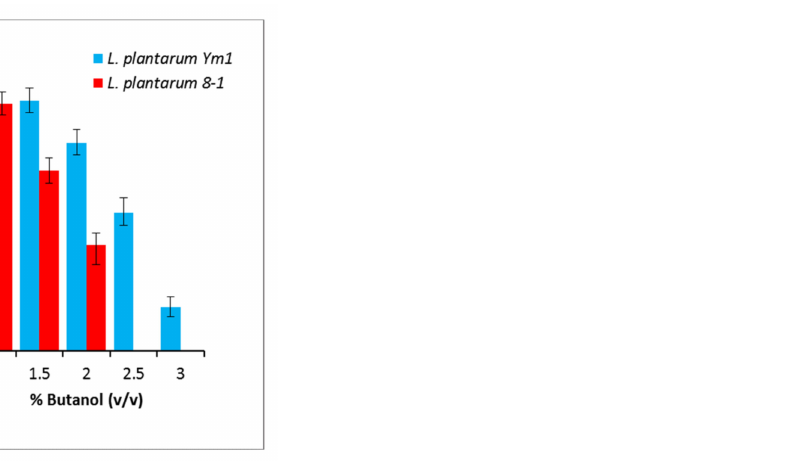
Figure 1. Relative growth rates of L. plantarum Ym1 and L. plantarum 8-1 in MRS medium supple- mented with 1%–3% ( v / v ) butanol. Growth in MRS without butanol is considered as 100%. The presented standard deviations are obtained from at least three different experiments.